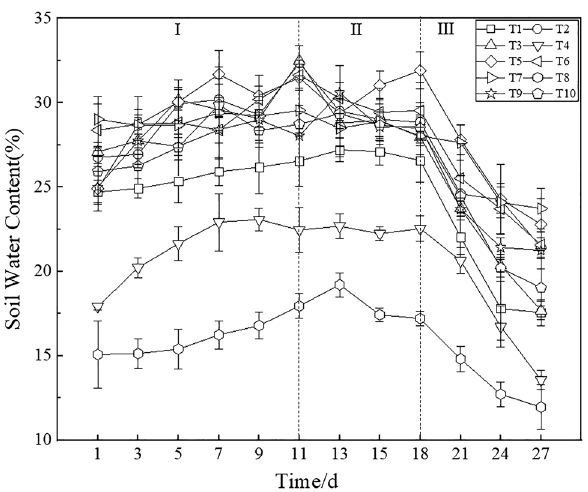
Figure 6. Soil water content under the different treatments (I, II, and III indicate the three stages of soil water content change).